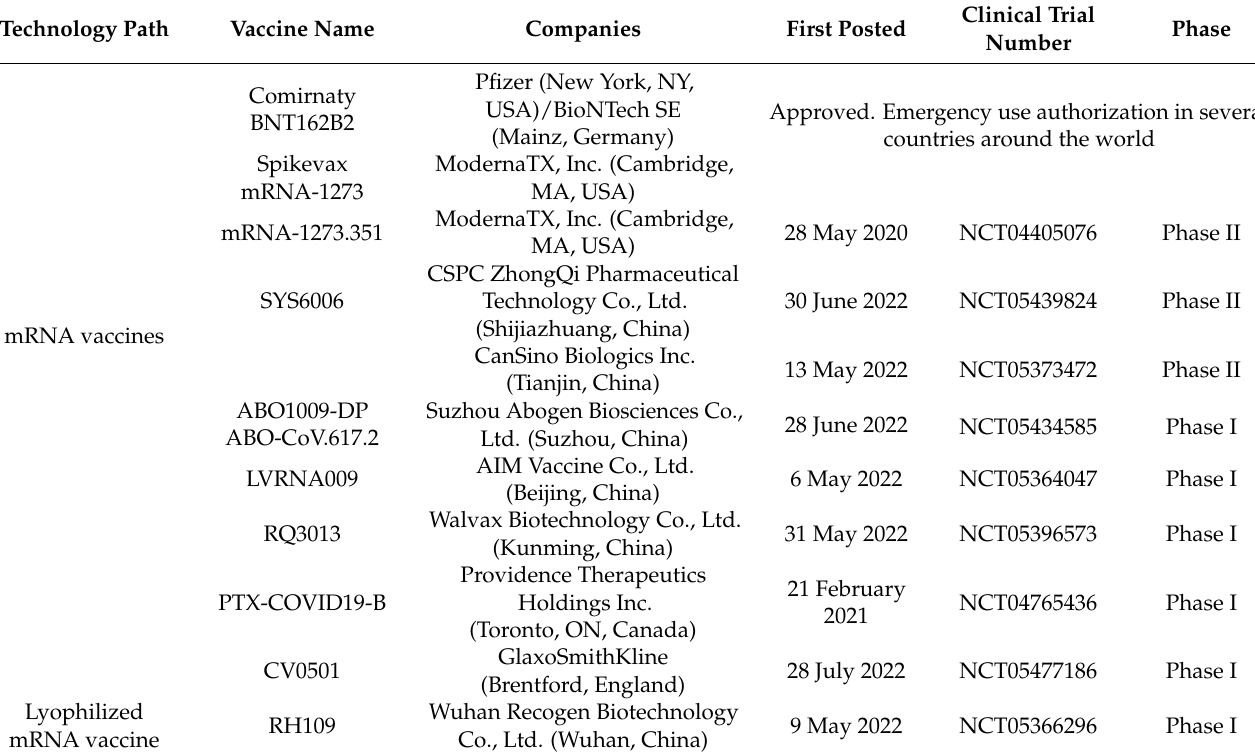
Table 1. The mRNA vaccines for COVID-19 that have been approved or in clinical